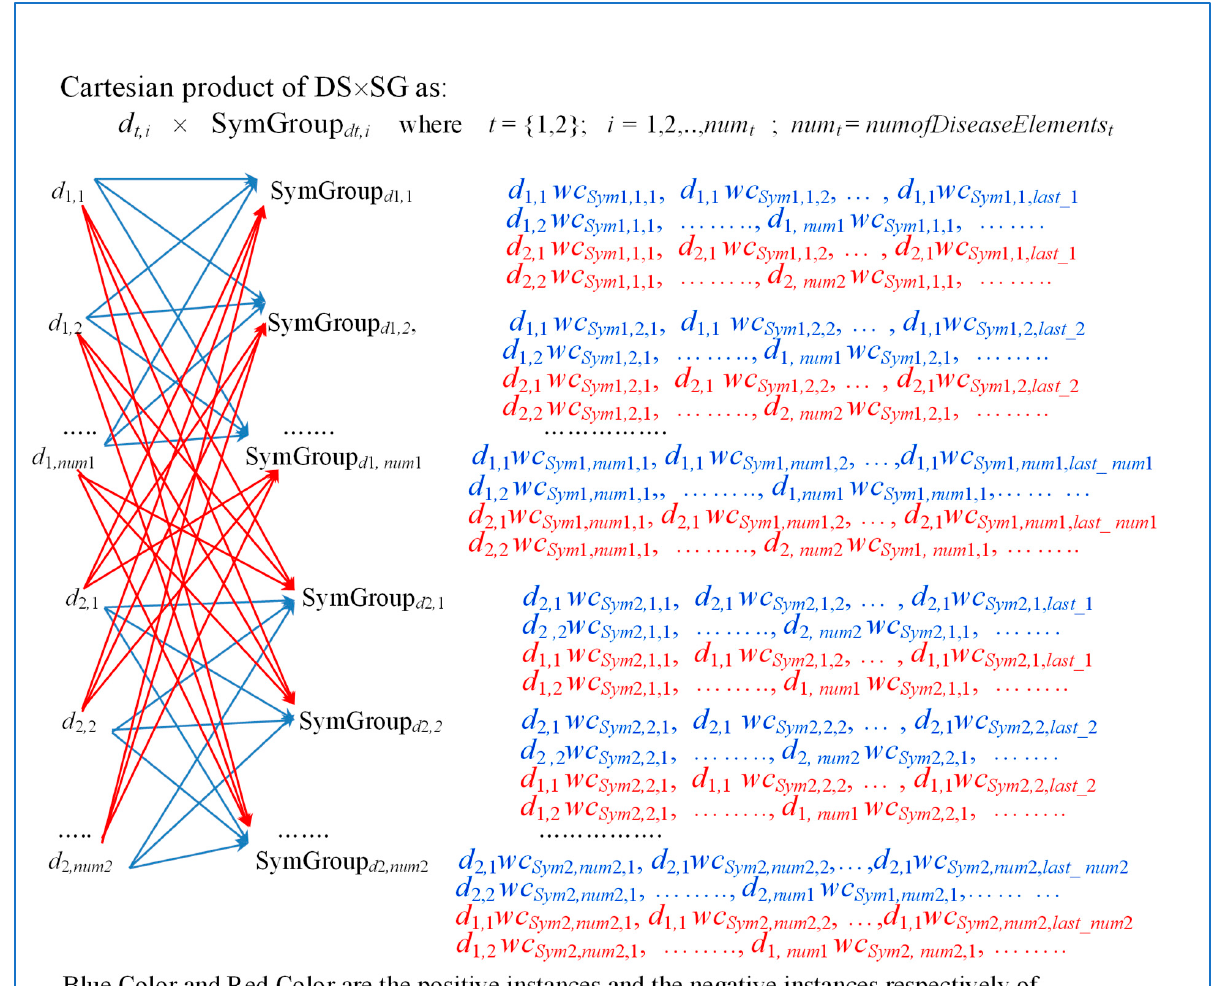
Figure 4. The positive and negative sample instances from the result of the Cartesian product of DS × SG.